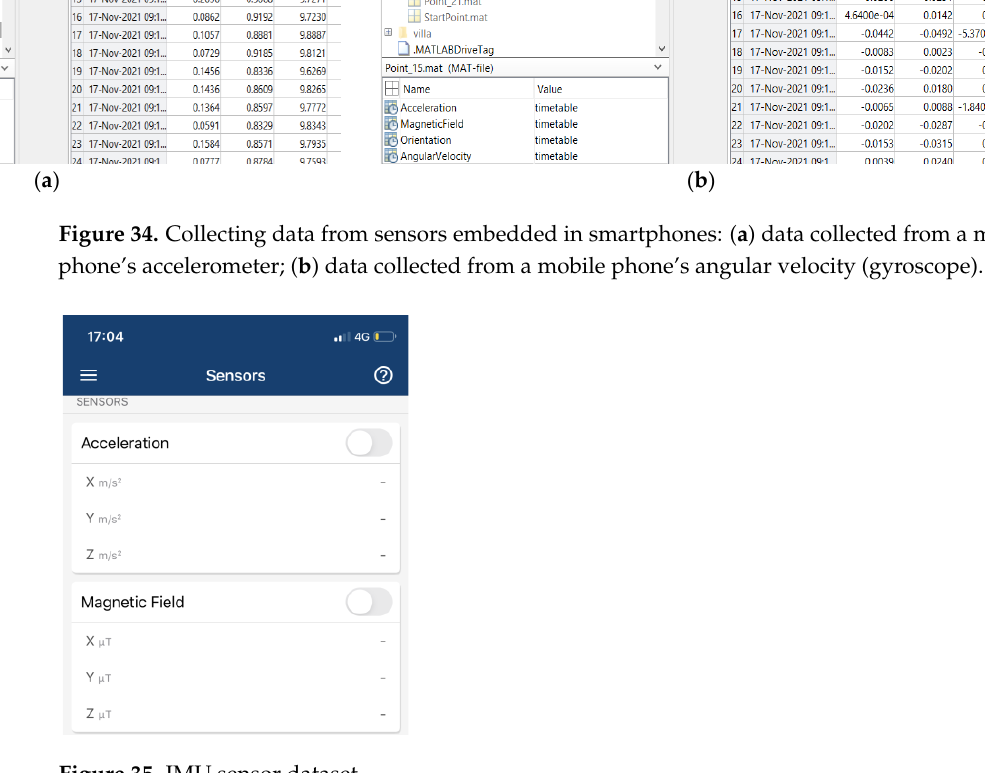
Figure 35. IMU sensor